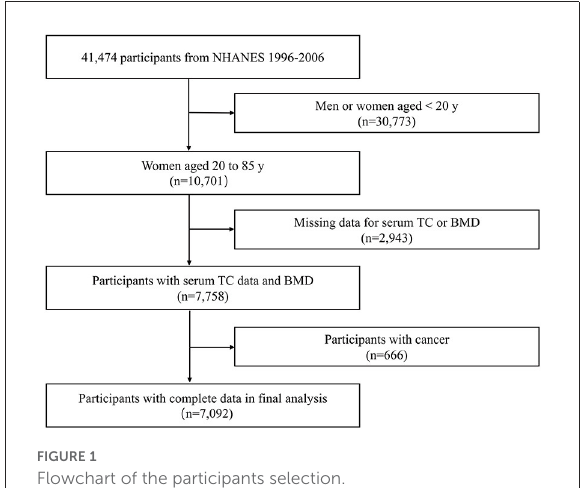
FIGURE1 Flowchart of the participants